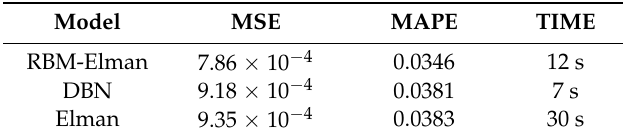
Figure 9. The forecasting results of seven consecutive days by the DBN model and Elman model are illustrated in Figures 10 and 11, respectively. Table 2. Forecast results by different models.